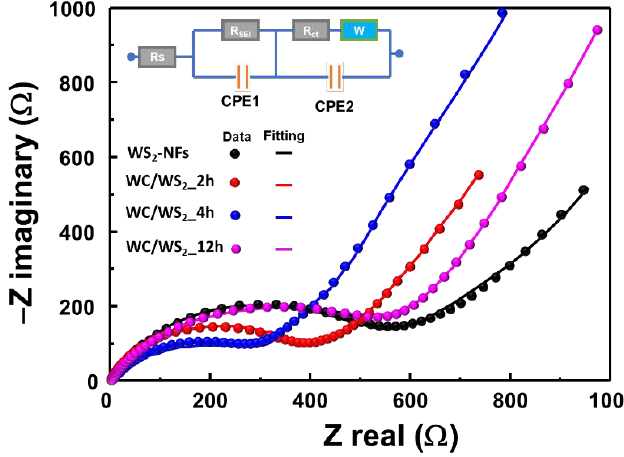
Figure 7. Nyquist plots of the as-prepared WS 2 NF, W 2 C/WS 2 _2h NF, W 2 C/WS 2 _4h NF, and 253 W 2 C/WS 2 _12h NF electrodes with inset equivalent circuit. 254 Table 1. Comparison of resistance values extracted from equivalent circuit for the electrochemical 255 impedance spectroscopic (EIS)